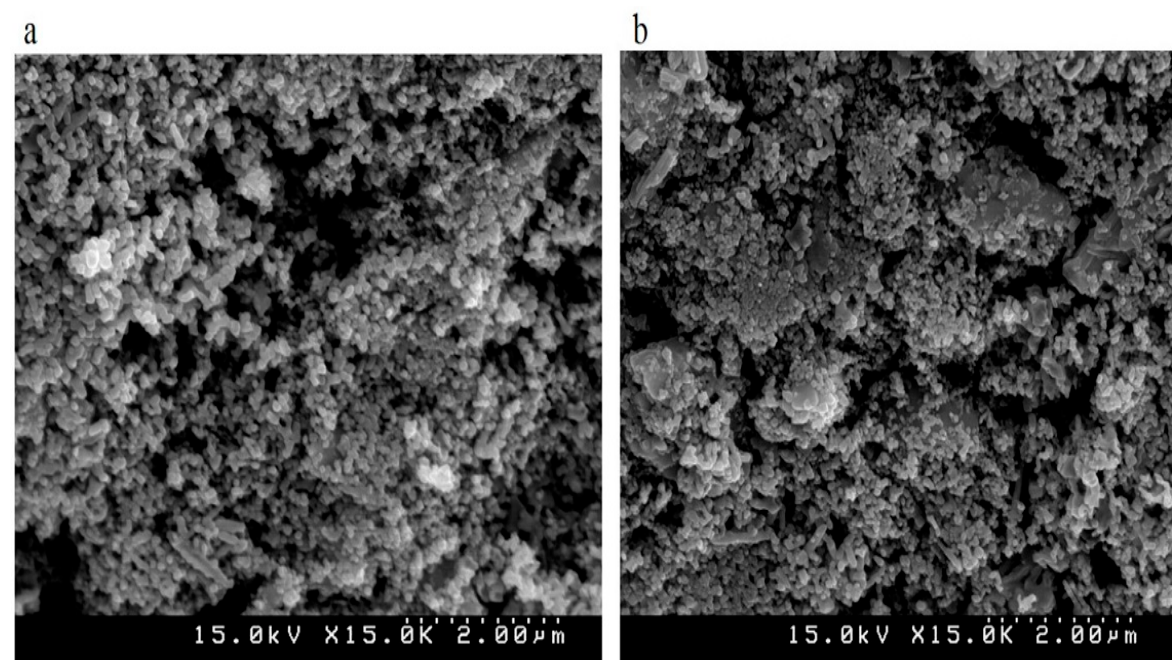
Figure 3. The SEM image of ( a ) Tb 0.04 Cd 0.96 Se and ( b ) Tb 0.08 Cd 0.92 Se nanoparticles.